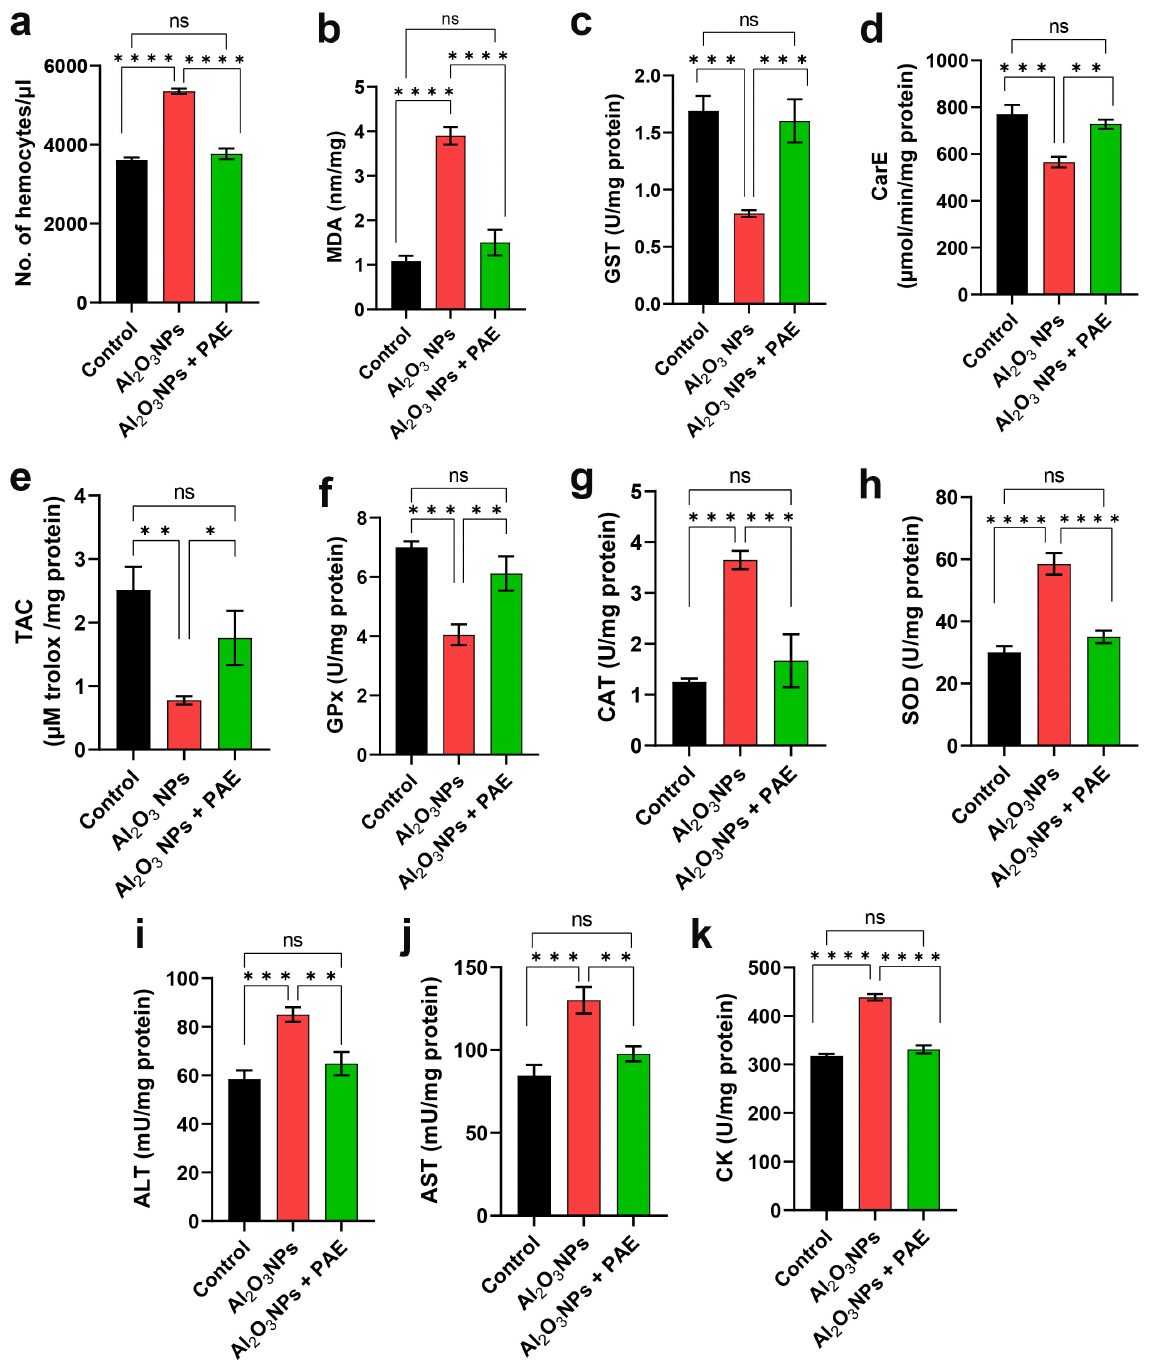
Figure 4. This is a figure. Schemes follow the same formatting. If there are multiple panels, they Figure 4. Biochemical analyses of testicular tissues after Al 2 O 3 NPs injection in L. migratoria should be listed as: ( a ) Description of what is contained in the first panel. ( b ) Description of what is contained in the second panel. Figures should be placed in the main text near to the first time they are cited. A caption on a single line should be centered.